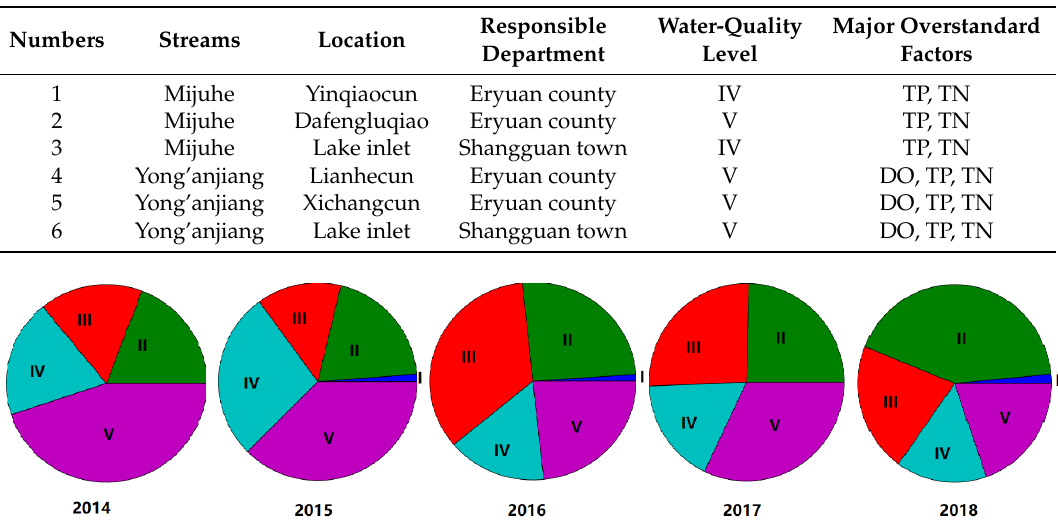
Table 2. Water quality of Erhai Lake and its main streams, published by Dali Bai Autonomous Prefecture Environmental Protection Agency, in October 2018.